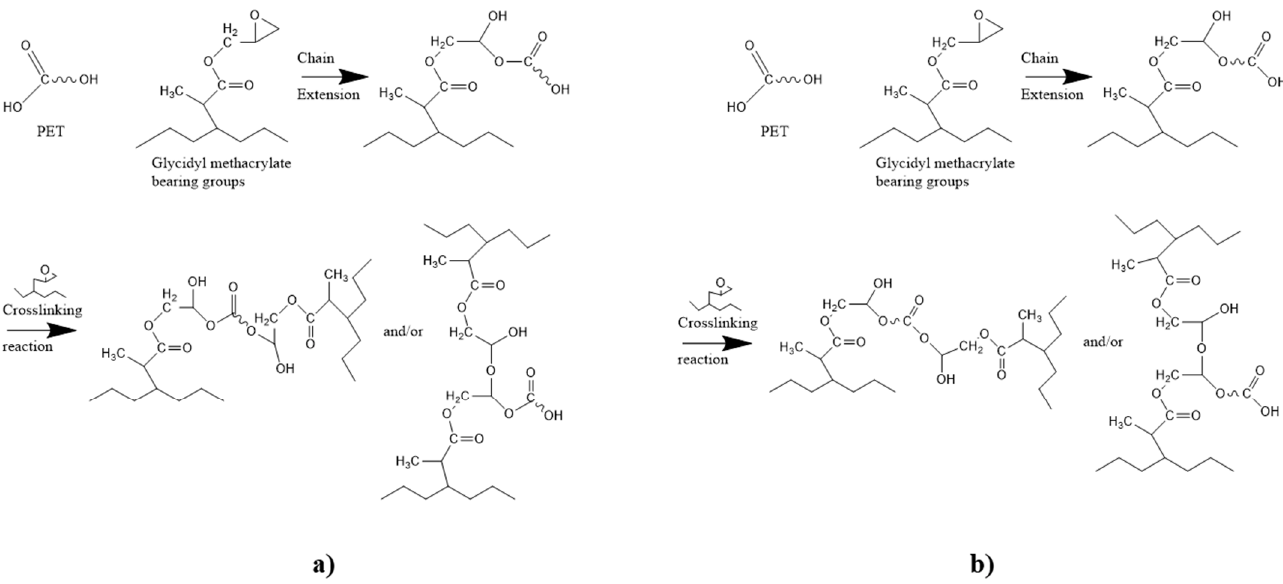
Figure 18. Chemical reactions between rPET and GMA function. ( a ) Chain extension with OH end group and crosslinking ( b ) chain extension with COOH end group and crosslinking. Reproduced under terms of the CC-BY license with permission [335].